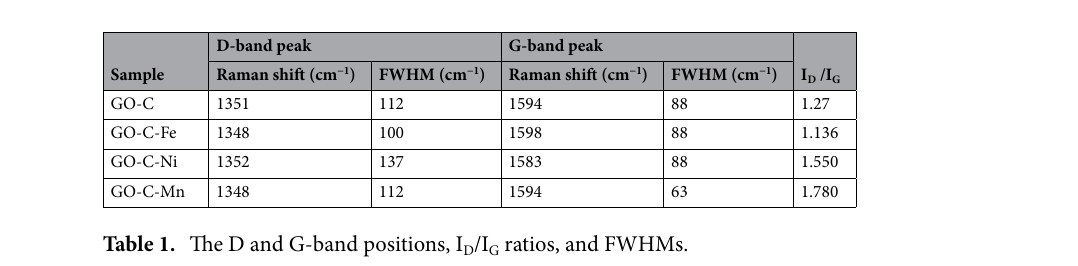
Table 1. The D and G-band positions, I D /I G ratios, and FWHMs.